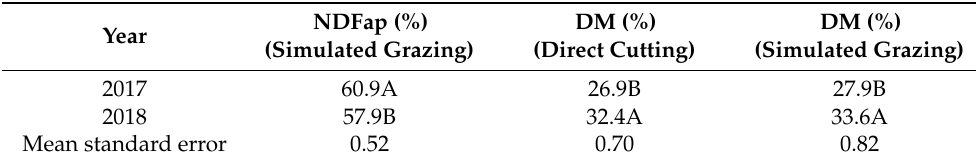
Table 8. Averages of the neutral detergent fiber corrected for ash and protein (NDFap), in samples from simulated grazing and percentages of dry matter (DM), via direct cutting and simulated grazing, at the end of the deferral period in two experimental years. NDFap (%) DM (%) DM Year (Simulated Grazing) (Direct Cutting)